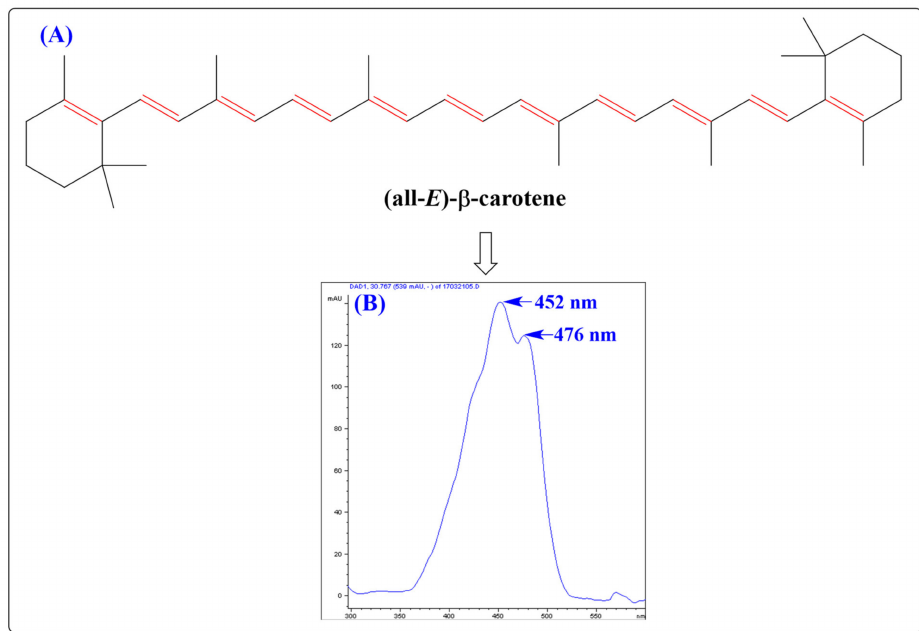
Figure 1. The molecular structure of chromophore of (all- E )- β -carotene ( A ), responsible for the absorption of light in the visible range. The absorbance spectrum of (all- E )- β -carotene ( B ) is from carrots recorded using a diode array detector (DAD) in the solvent system previously used in our study [29] (unpublished